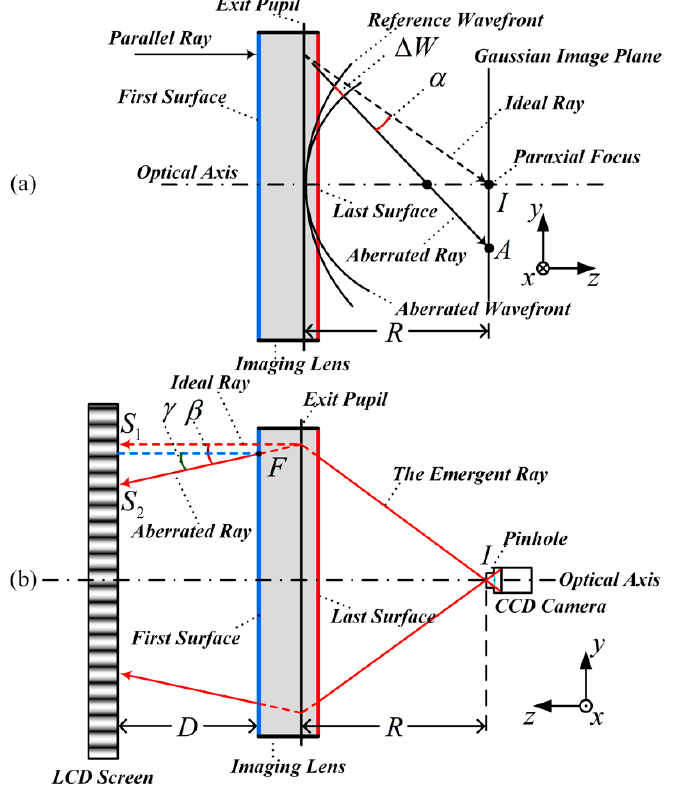
Figure 1. ( a ) Schematic angular aberration and wavefront aberration; ( b ) ray sketch of WAMD